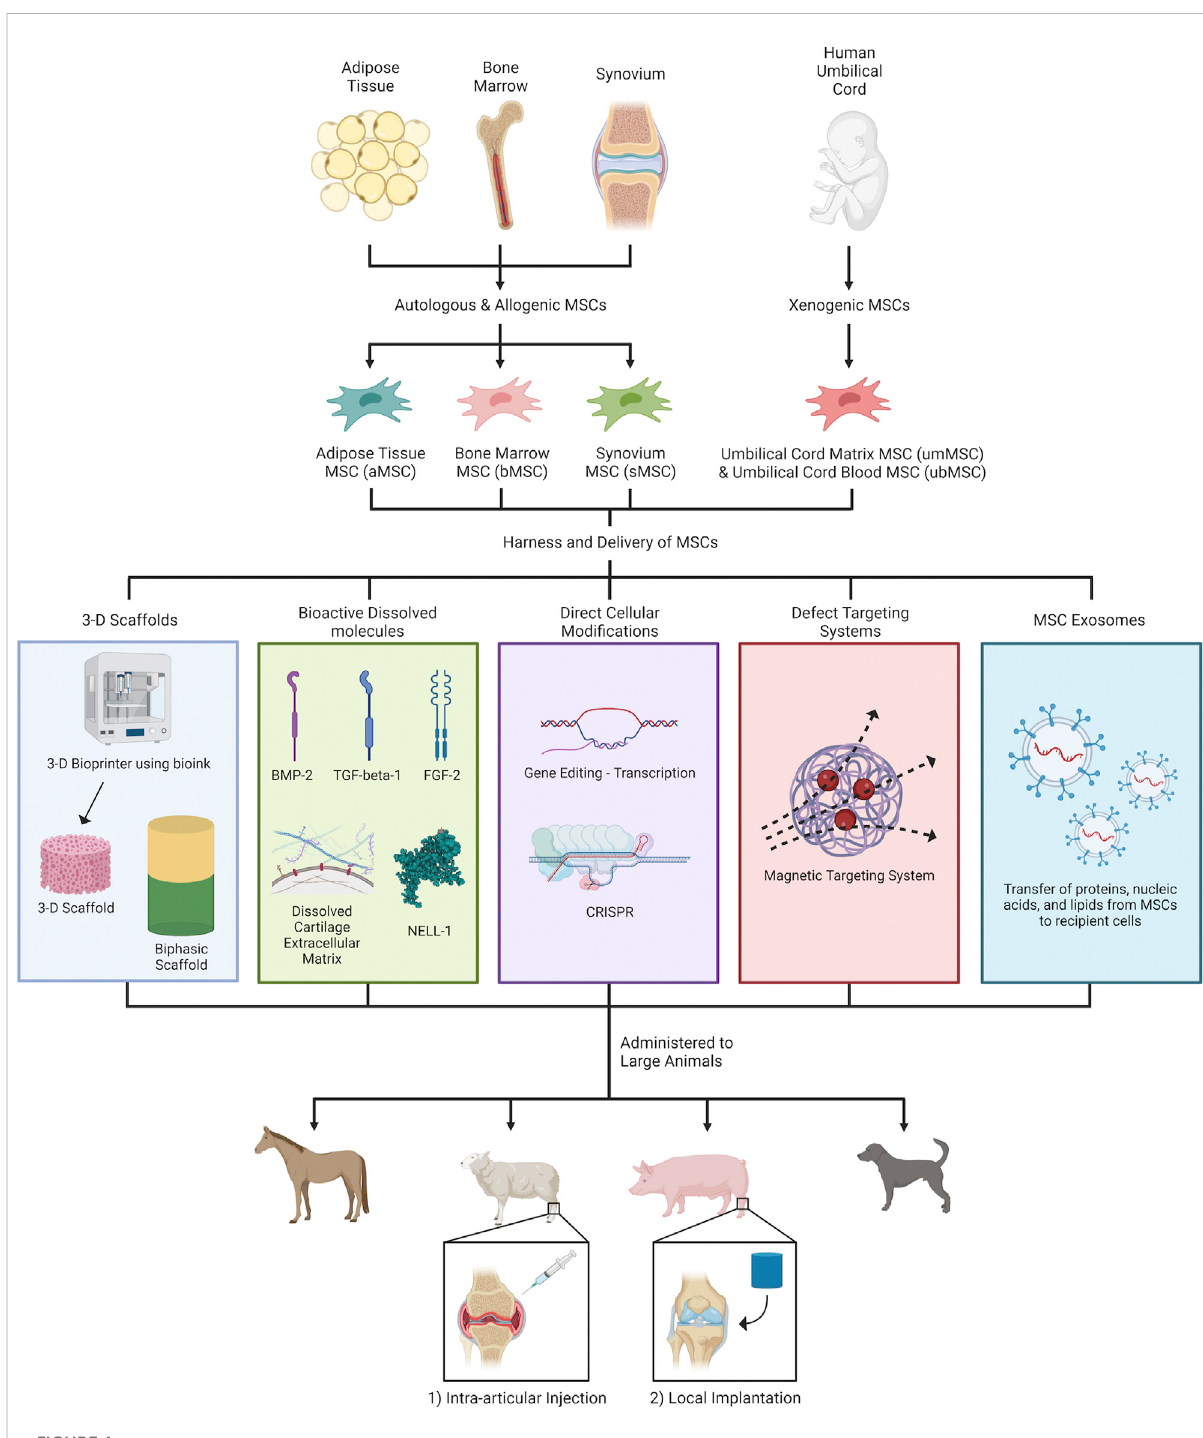
FIGURE 1 MSC-harnessing strategies for articular cartilage regeneration in large animal models. Different types of MSCs — autologous, allogenic and xenogenic — were fi rstobtainedfromadiposetissue(aMSC),bonemarrow(bMSC),synovium(sMSC),andhumanumbilicalcords(umMSC&ubMSC). Subsequently, MSCs were pretreated with and/or delivered through (1) 3-D scaffolds, (2) bioactive dissolved molecules, (3) direct cellular modi fi cations, (4) defect targeting systems, and (5) cell-free MSC-derived exosomes, for enhancing cartilage regeneration and/or modulating in fl ammation. Currently, the two major routes of MSC administration in preclinical large animal studies are intra-articular injection and local implantation within chondral/osteochondral defects. Figure created with